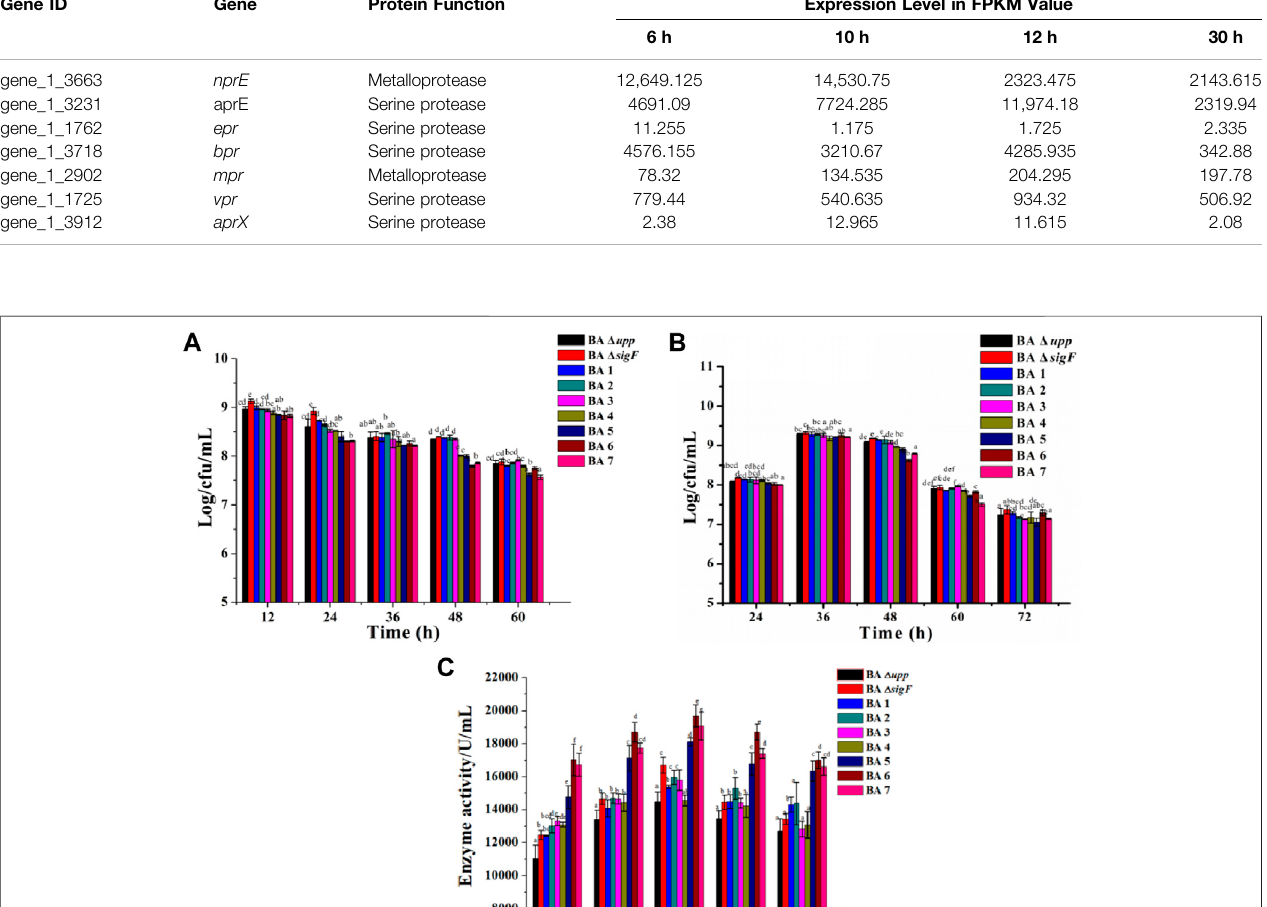
Frontiers in Bioengineering and Biotechnology |